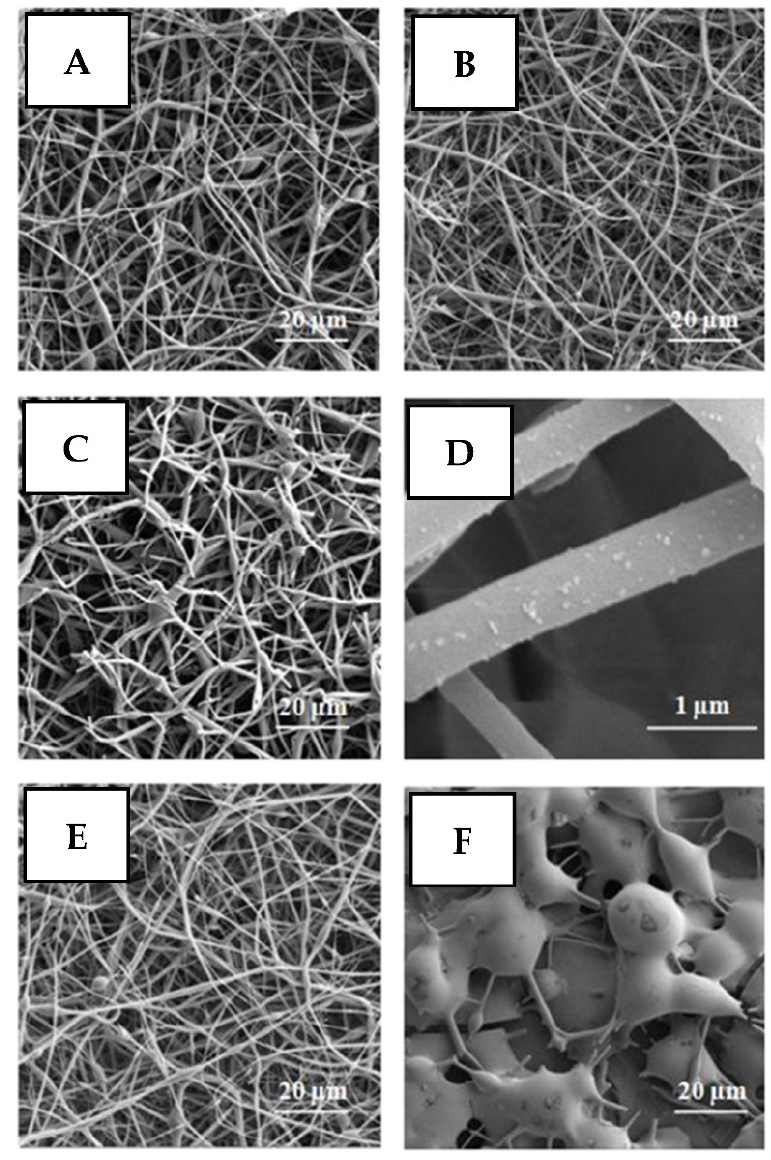
Figure 3. Scanning electron microscopy images of nanofibers prepared by electrospinning from poly(methyl methacrylate) (PMMA) and tetraphenyl porphine (TPP) solutions in chloroform: ( A ) as-prepared Ag/TPP/PMMA nanofibers; ( B ) Ag/TPP/PMMA nanofibers after treatment with light- emitting diode (LED); ( C ) Ag/TPP/PMMA nanofibers after 20-h laser treatment; ( D ) the magnified image of the laser-treated Ag/TPP/PMMA nanofibers; ( E ) TPP/PMMA nanofibers without Ag; ( F ) TPP/PMMA nanofibers without Ag after diode treatment for 20 h. Reprinted with permission from ref. [95]. Copyright 2016 Elsevier.